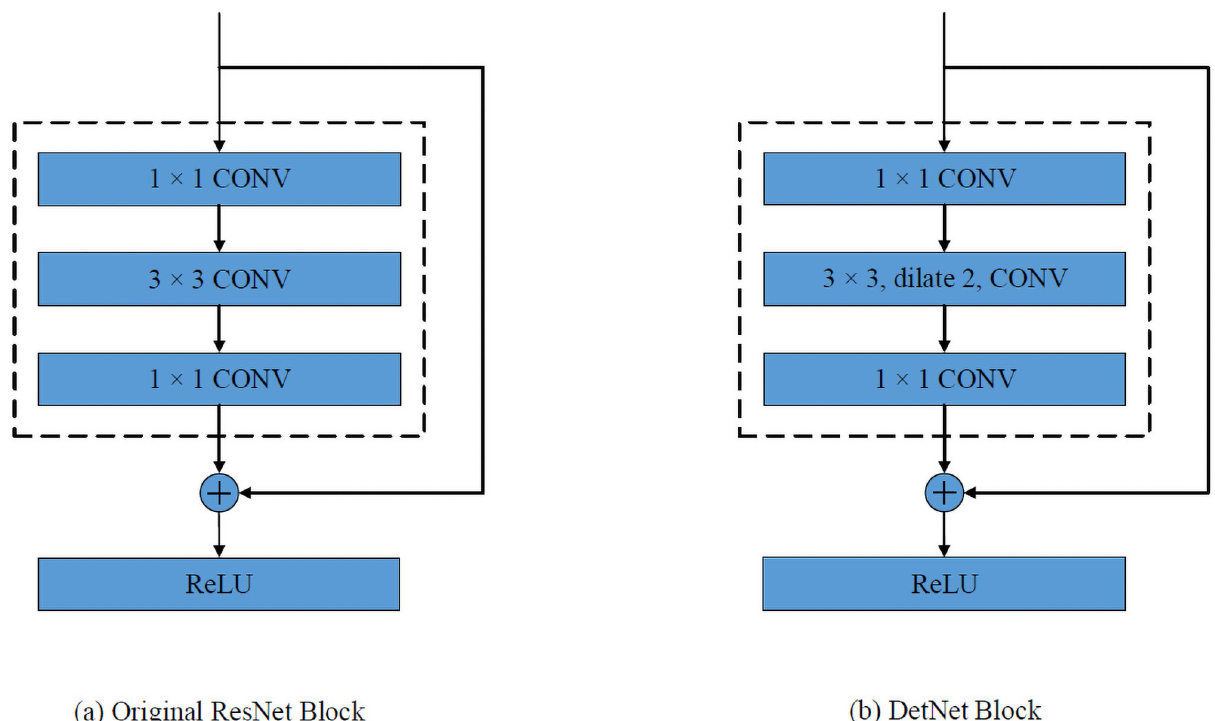
Fig 3. DetNet structure. The diagram shows the basic building block of ResNet [55] and DetNet [66]. (a) After each ResNet block, the resolution is reduce in half. (b) The DetNet preserves the feature map resolution and increases the receptive field by using dilated convolutions.